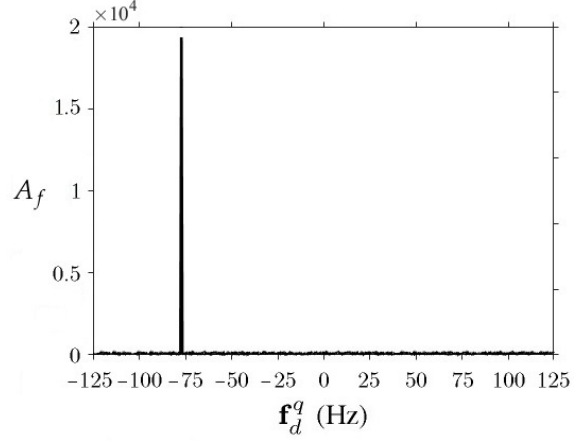
Figure 5. Sparse vector ˜¯ A for estimating major-band ( N s = 0) Doppler shift, ˜ f q